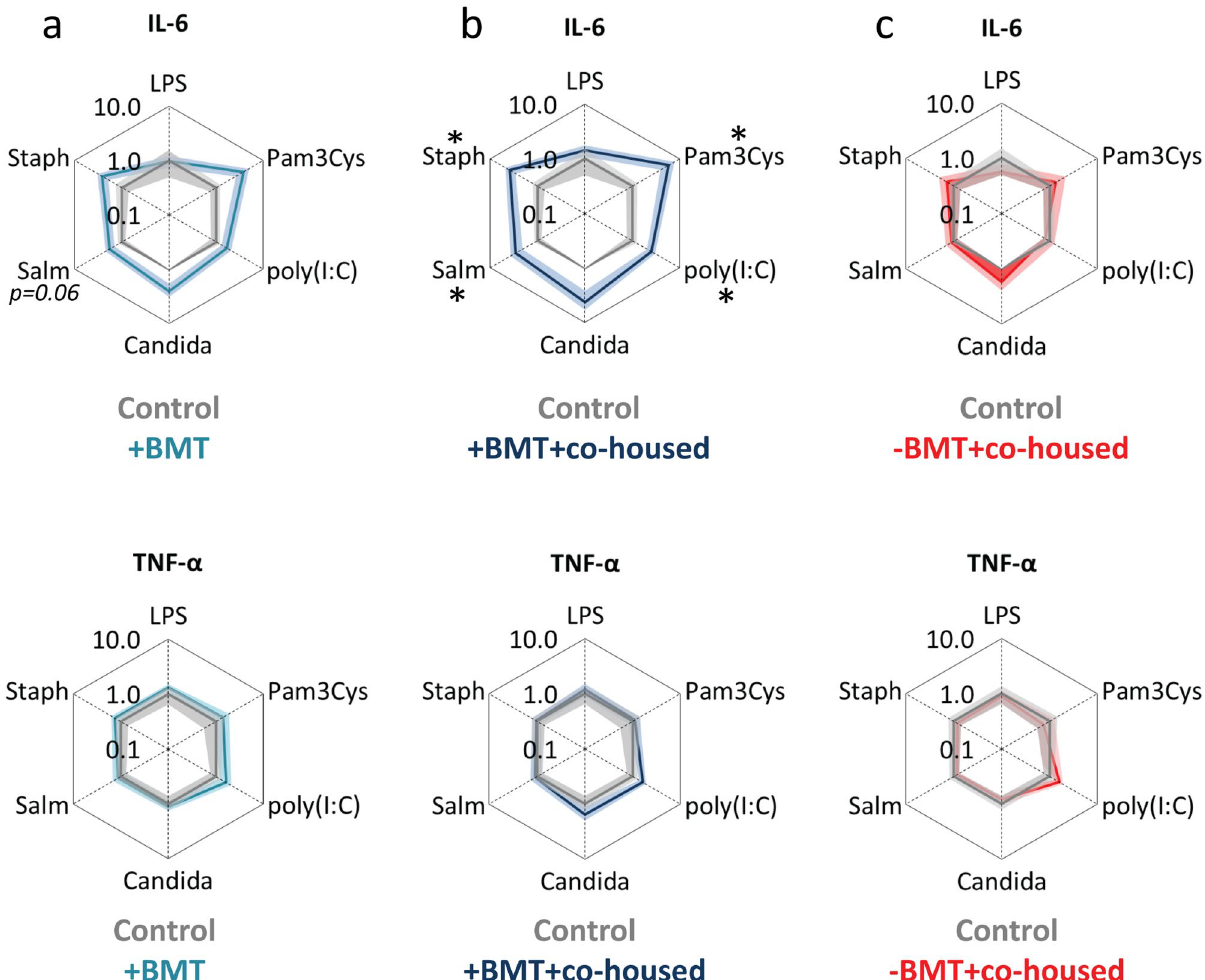
Figure 2. The effect of co-housing after BMT on cytokine secretion of stimulated peritoneal macrophages. Spiderplots show IL-6 and TNF-α release in response to various pathogenic stimuli from peritoneal macrophages derived from ( a ) BMT-treated mice co-housed with BMT mice (outer light blue lines), ( b ) BMT-treated mice co-housed with healthy control mice (outer dark blue lines), and ( c ) control co-housed mice co-housed with BMT-treated mice (outer red lines). Cytokine concentrations in response to the stimuli are normalized to the cytokine concentrations of healthy control mice co-housed with control mice (inner grey lines), averaged per group and plotted on a log scale. See legend to Fig. 1 for more information. Groups were compared using Mann–Whitney U test; n = 6; *p < involved in the altered cytokine response pattern by splenocytes after BMT, germfree mice were inoculated with the cecum content of BMT-treated mice co-housed with or without control mice or with the cecum content of co-housed control mice. Splenocytes derived from germfree mice that were colonized with cecum content of BMT-treated mice as compared to those colonized with cecum content of control mice, secreted more cytokines after stimulation with various pathogenic stimuli, which reached significance for LPS (IL-22 and TNF-α), PHA (IL-10 and TNF-α), poly(I:C) (IL-10, IL-22 and TNF-α) and C. conidia (IL10 and TNF-α) (outer light blue lines versus inner grey lines, Fig. 3a). A partly overlapping cytokine response pattern was observed in germfree mice inoculated with cecum content of BMT-treated mice co-housed with BMT mice and in germfree mice inocu- lated with cecum content of BMT-treated mice co-housed with control mice (outer light and dark blue lines versus inner grey lines, Fig. 3a,b), with similar (trends in) responses of IL-10, IL-22 and TNF-α secretion to PHA stimulation. Remarkably, splenocytes derived from germfree mice colonized with cecum content of control mice co-housed with BMT-treated mice showed a cytokine response pattern very similar to splenocytes from germfree mice that were colonized with cecum content of BMT-treated mice (outer red lines and light blue lines versus inner grey lines, Fig. 3a,c). The IL-10 response to PHA, poly (I:C) and C. conidia were identical, as was the TNF-α response to LPS and C. conidia. These data are in line with the results derived from the co-housing experiment and indicate that the increased responsiveness of splenocytes after BMT can be largely transferred by cecum content transplantation. Peritoneal macrophages of germfree mice inoculated with cecum content of BMT-treated mice and co-housed BMT-treated mice did not show increased IL-6 and TNF-α secretion upon stimulation (outer light blue and dark